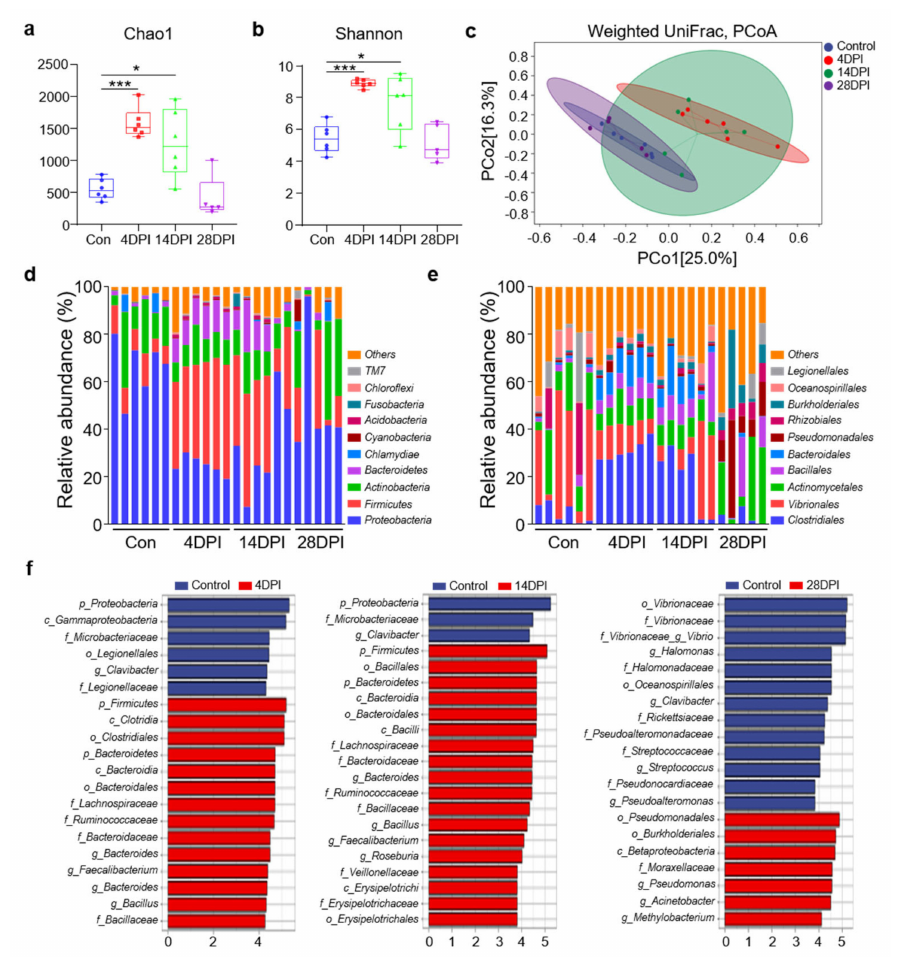
Figure 4. Changes in the composition and abundance of trout gut microbiota community in response to IHNV infection. ( a , b ) Richness and diversity of bacterial community in trout gut from control and infected groups. Richness and diversity of the gut bacterial community were measured using Chao1 and Shannon index. Error bars represent standard error of mean (SEM). (*) p < 0.05, (***) p < 0.001 (unpaired Student’s t − test). ( c ) Weighted UniFrac compositional − based distances were computed for control (blue − colored), 4 DPI (red − colored), 14 DPI (green − colored), and 28 DPI (pink − colored) groups, respectively. The principal coordinate analysis (PCoA) results are presented as two − dimensional ordination plots, which were generated using two (PCo1 and PCo2) principal coordinates. ( d , e ) Composition and relative abundance of the top 10 dominant bacterial taxa in the gut of rainbow trout in control fish and IHNV − infected fish at 4, 14, and 28 DPI at the phylum ( d ) and order ( e ) levels. ( f ) LEfSe cladogram of differentially abundant taxa in control and IHNV − infected fish at 4, 14, and 28 DPI (phylum (p), class (c), order (o), family (f), genera